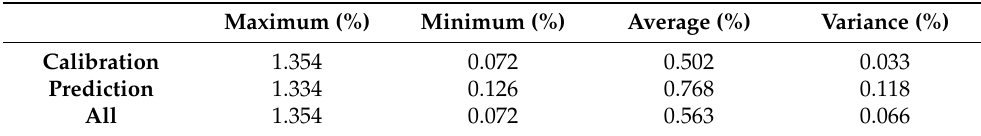
Table 2. Results of the nitrogen content analysis of Pinus massoniana seedling